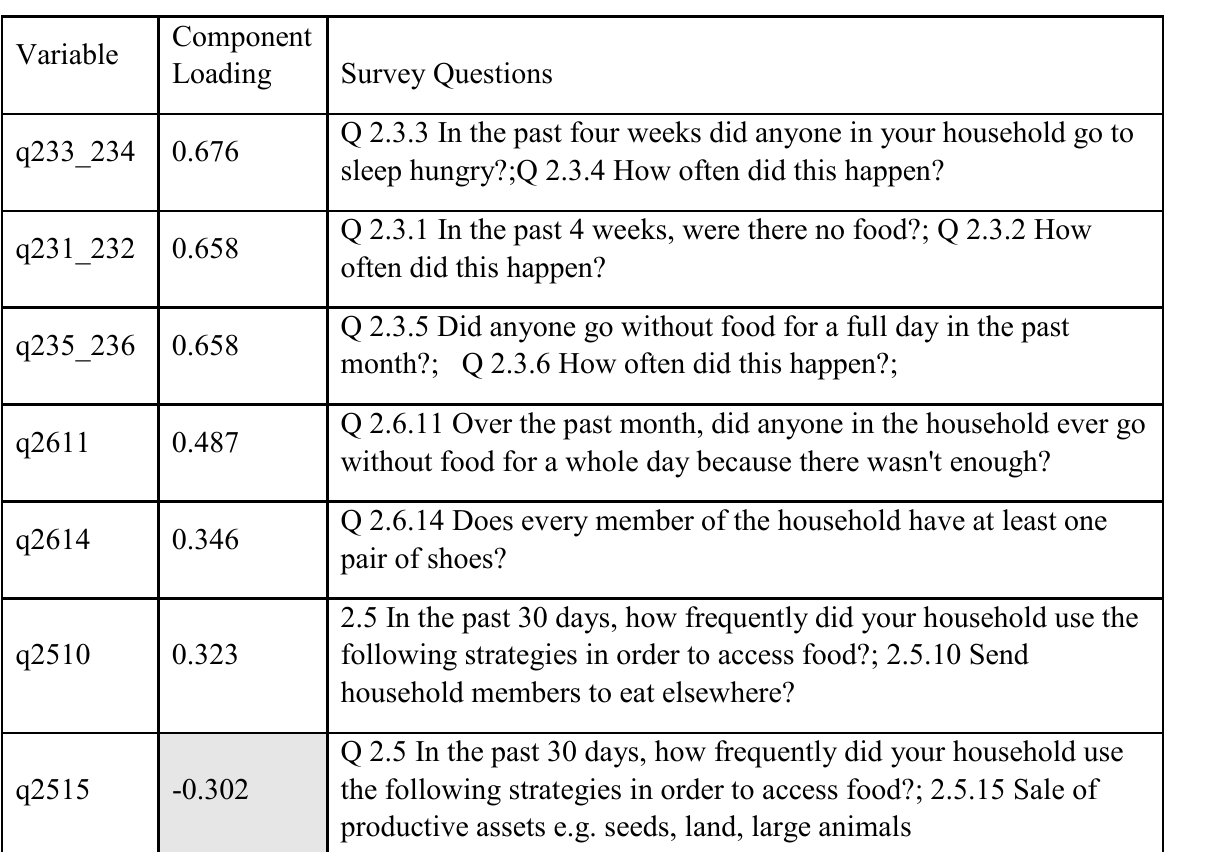
Table 1.6: Variables defining Absorptive Resilience PC3